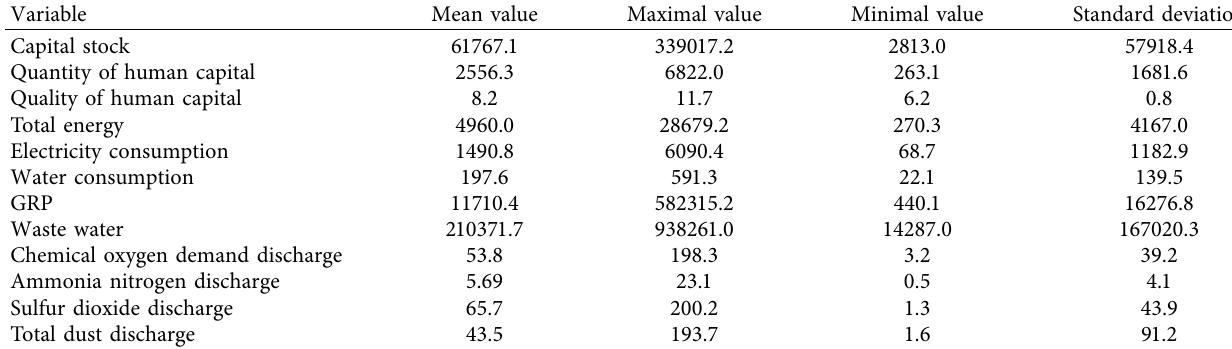
Table 1: Descriptive statistics of input and output variables.